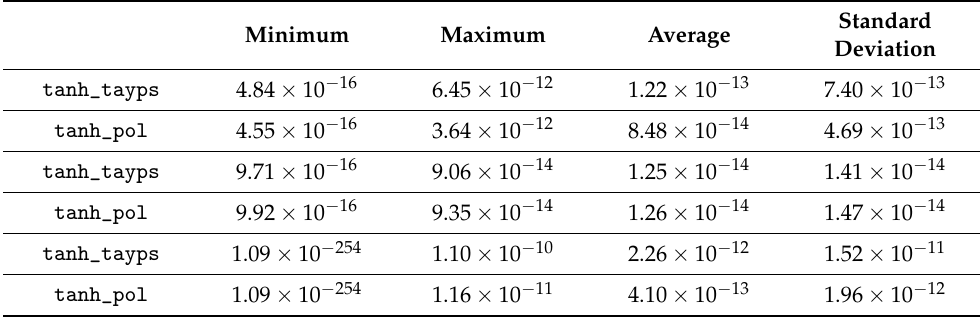
Table 7. The minimum, maximum, and average values and the standard deviation of the relative errors committed by tanh_tayps and tanh_pol for Tests